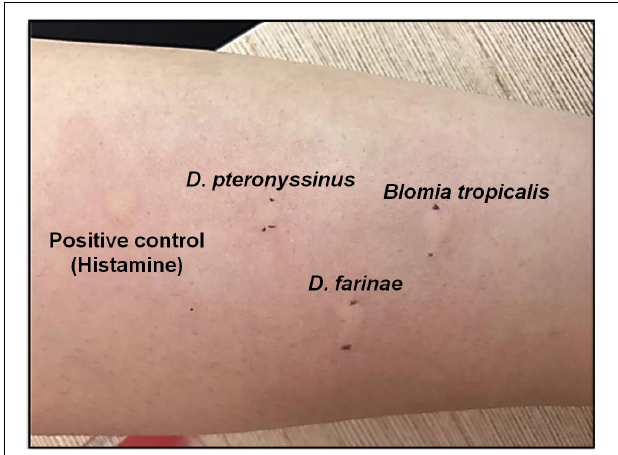
FIGURE 1 | Positive SPT of HDM allergen Dermatophagoides pteronyssinus ( D. pteronyssinus; wheal size 9 mm), Dermatophagoides farinae ( D. farinae ; wheal size 11 mm) and Blomia tropicalis ( B. tropicalis ; wheal size 10 mm) tested on an AR patient at ORL-HNS clinic, Hospital Universiti Sains